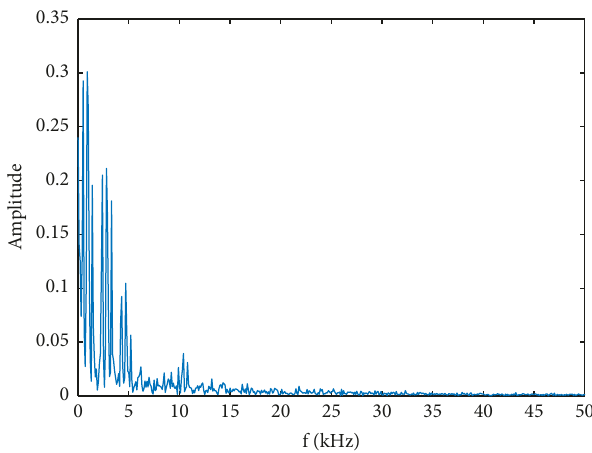
Figure 4: The frequency spectrum of the incident wave after FFT.